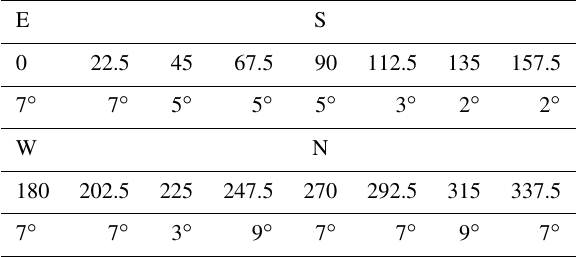
Figure 12. Simulated irradiance for different wavelengths and mountain heights, normalized to the irradiance at the corresponding wavelength without mountains ( θ m = 0 ◦ ). Note the scale change on the y axis indicated by the dashed, gray line. Blue lines are values outside totality, black lines during totality. Solid lines are for moun- tains with constant height everywhere around the observer, dashed lines represent the mountain profile P2017 given in Table 2. Table 2. Azimuth angle in degrees (second row) and corresponding height of the mountains over the horizon (third row) in degrees. Values taken from Bernhard and Petkov (2019).